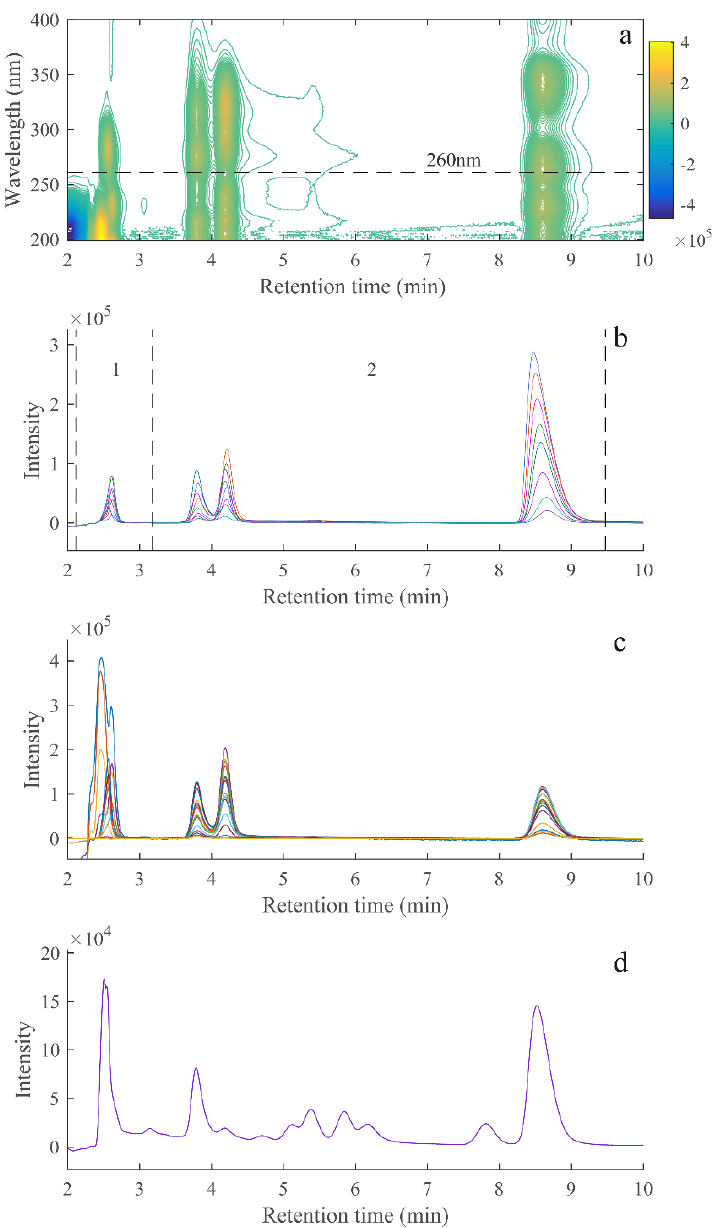
Figure 1. ( a ) Two − dimensional contour profile of a mixed standard solution (C06); ( b ) the elution time profiles at 260 nm for eight calibration samples; ( c ) multi − channel chromatographic profile of a mixed standard solution (C06); ( d ) the elution time profiles at 260 nm for six predicted samples.